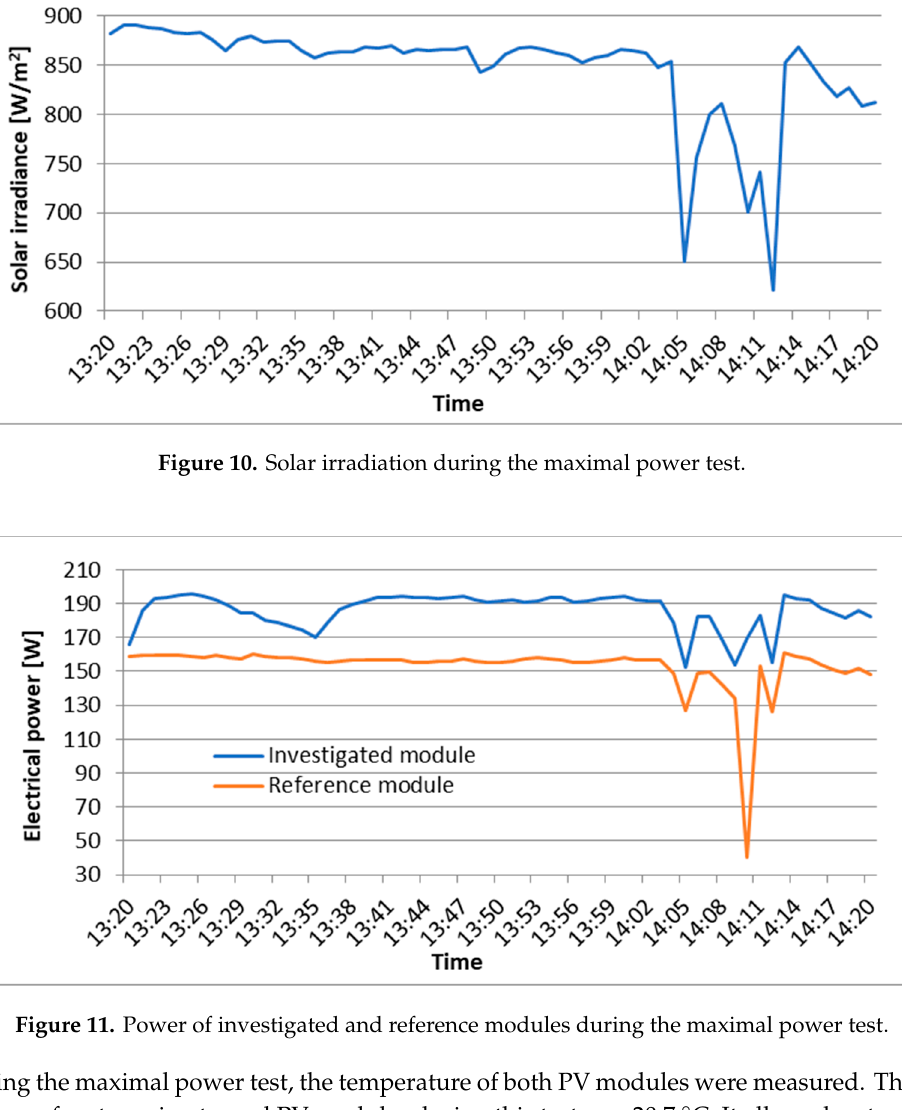
Figure 10. Solar irradiation during the maximal power test.